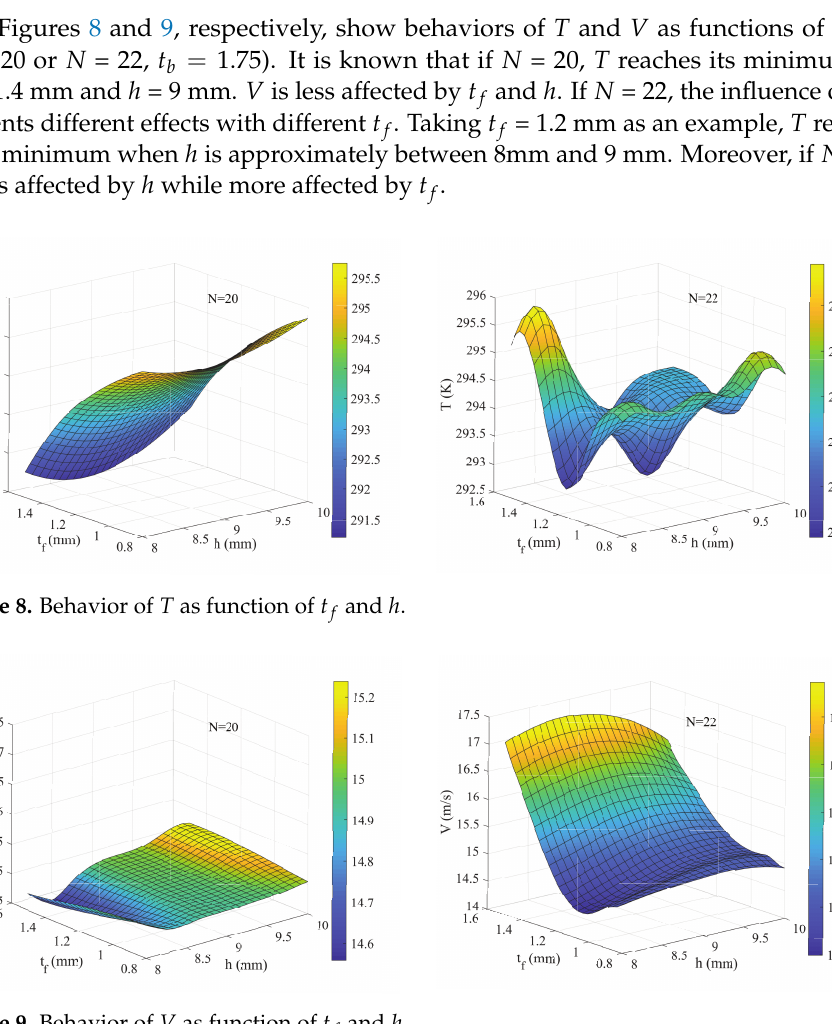
Figure 9. Behavior of V as function of t f and h